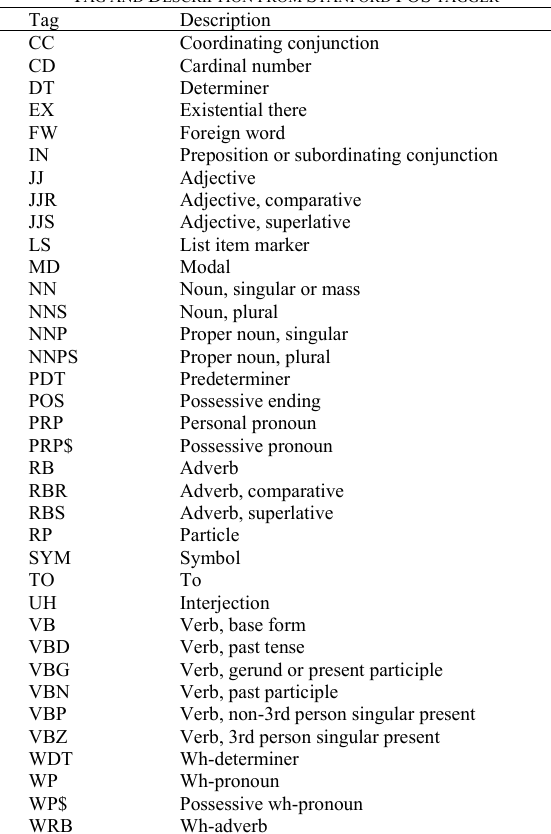
TABLE 3 T AG AND D ESCRIPTION FROM S TANFORD POS